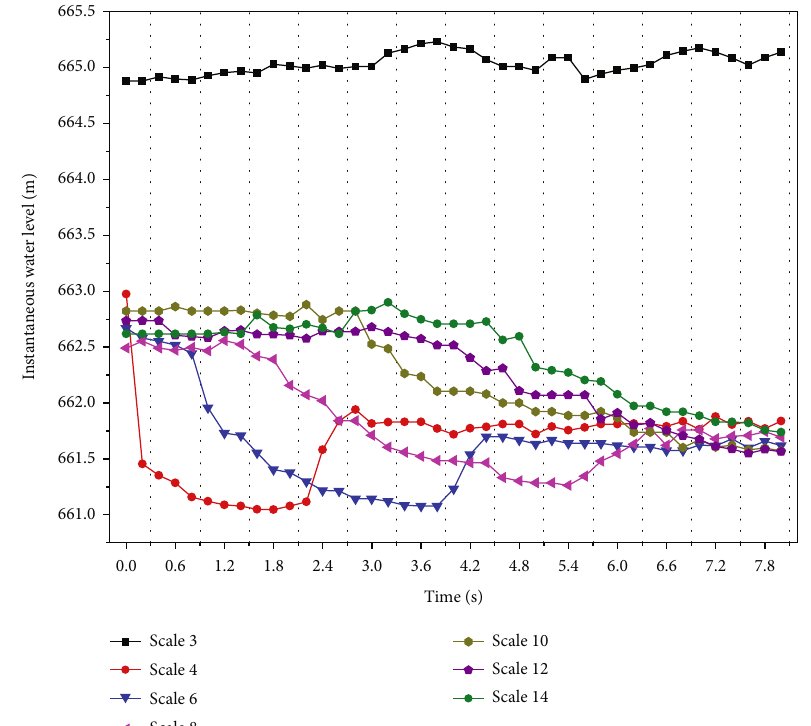
Figure 6: Instantaneous water level at each measuring point under operating condition 1 (interval 0.2s).